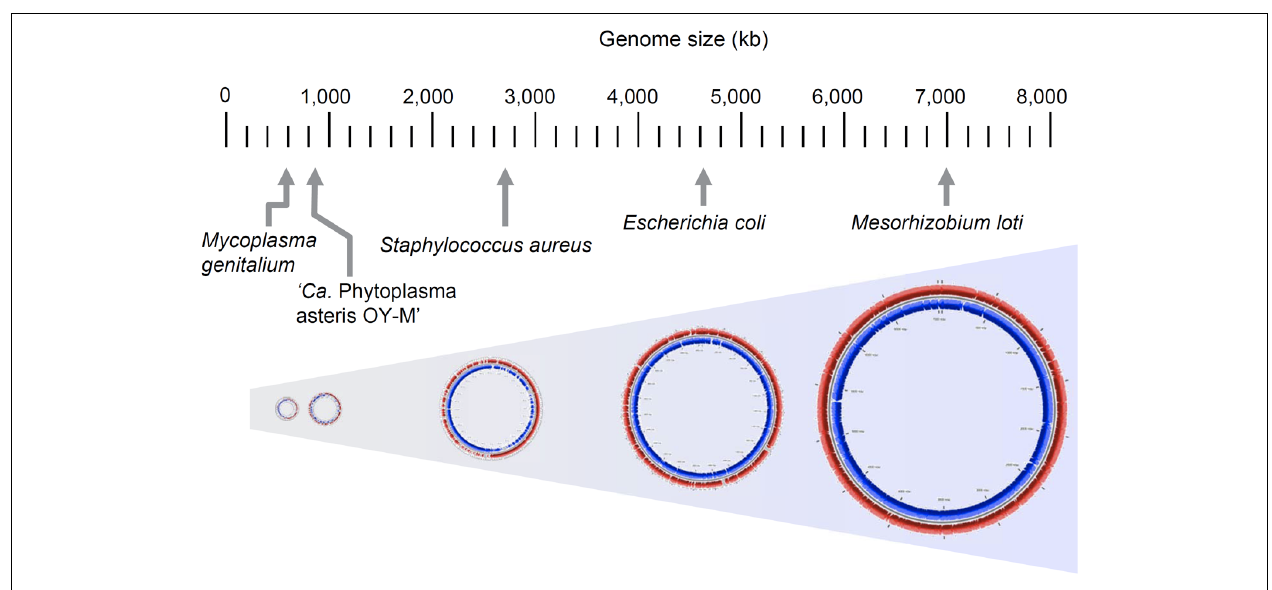
FIGURE 4 | Comparison of genome size in phytoplasma and other bacteria. Genome sizes of Mesorhizobium loti , Escherichia coli K-12 MG1655, Staphylococcus aureus subsp. aureus N315, ‘ Ca . P. asteris’ OY-M strain and Mycoplasma genitalium G37 are